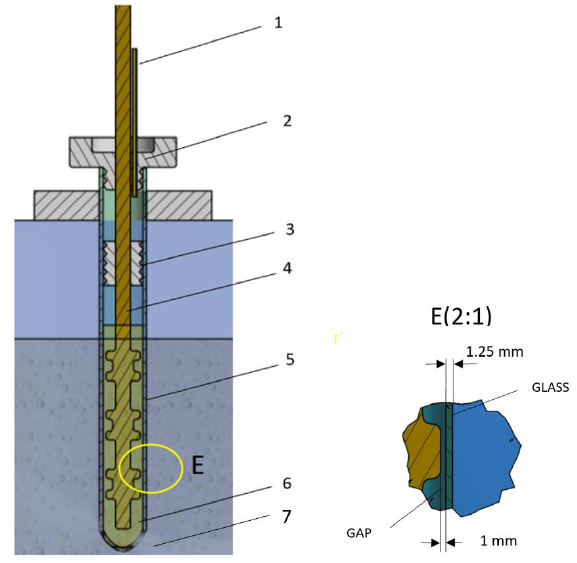
Figure 1. Aging cell under high electric field strength and PDs: 1 — fine tube for gases discharge, 2 — upper sealing plug, 3 — inner centering plug, 4 — brass inner high voltage electrode, 5 — glass test tube, 6 — mineral oil, and 7 — salt water.